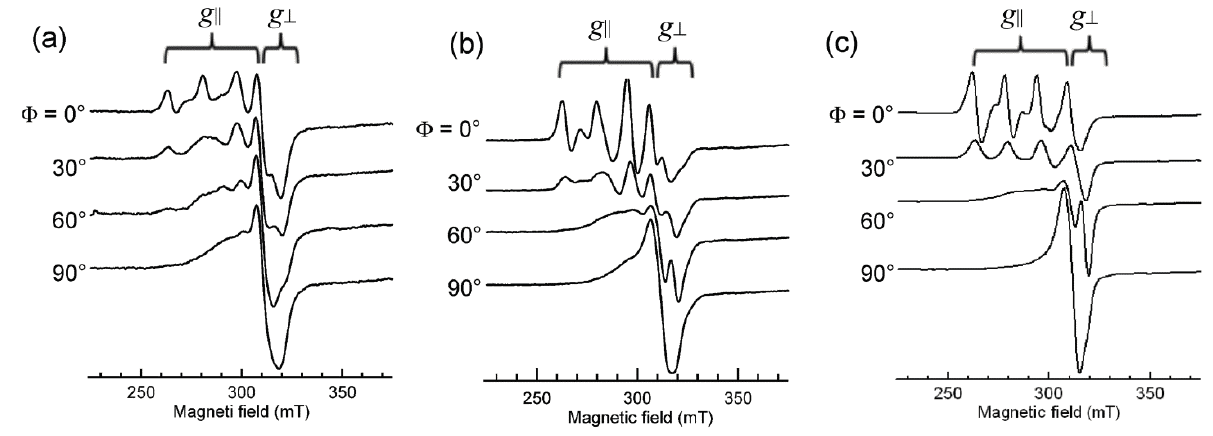
Figure 16. B-form DNA-fiber EPR spectra of ( a ) 1 , ( b ) 2 and ( c ) 3 at room temperature [60]. Φ is the angle between the static magnetic field and the DNA double-helical axis. The DNA fibers were prepared using the buffer solution (20 mM HEPES, 30 mM NaCl (pH 7.4)). [DNA-bp]/[complex] = 20.